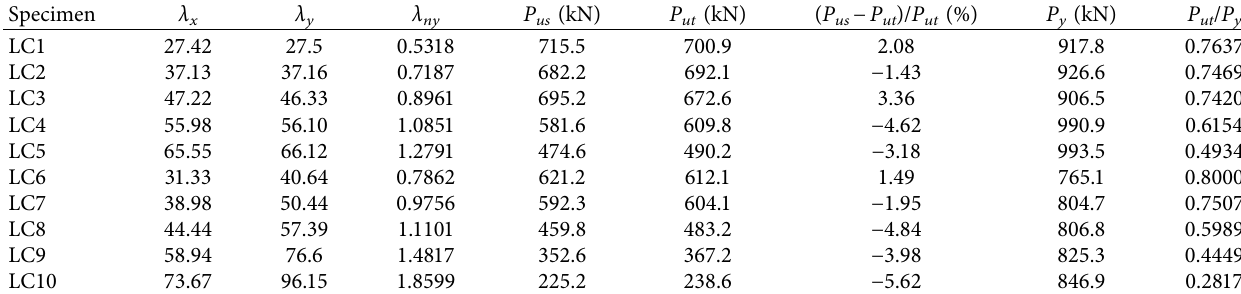
Table 5: Comparison between the test results and finite element simulation results of local and global interactive buckling.